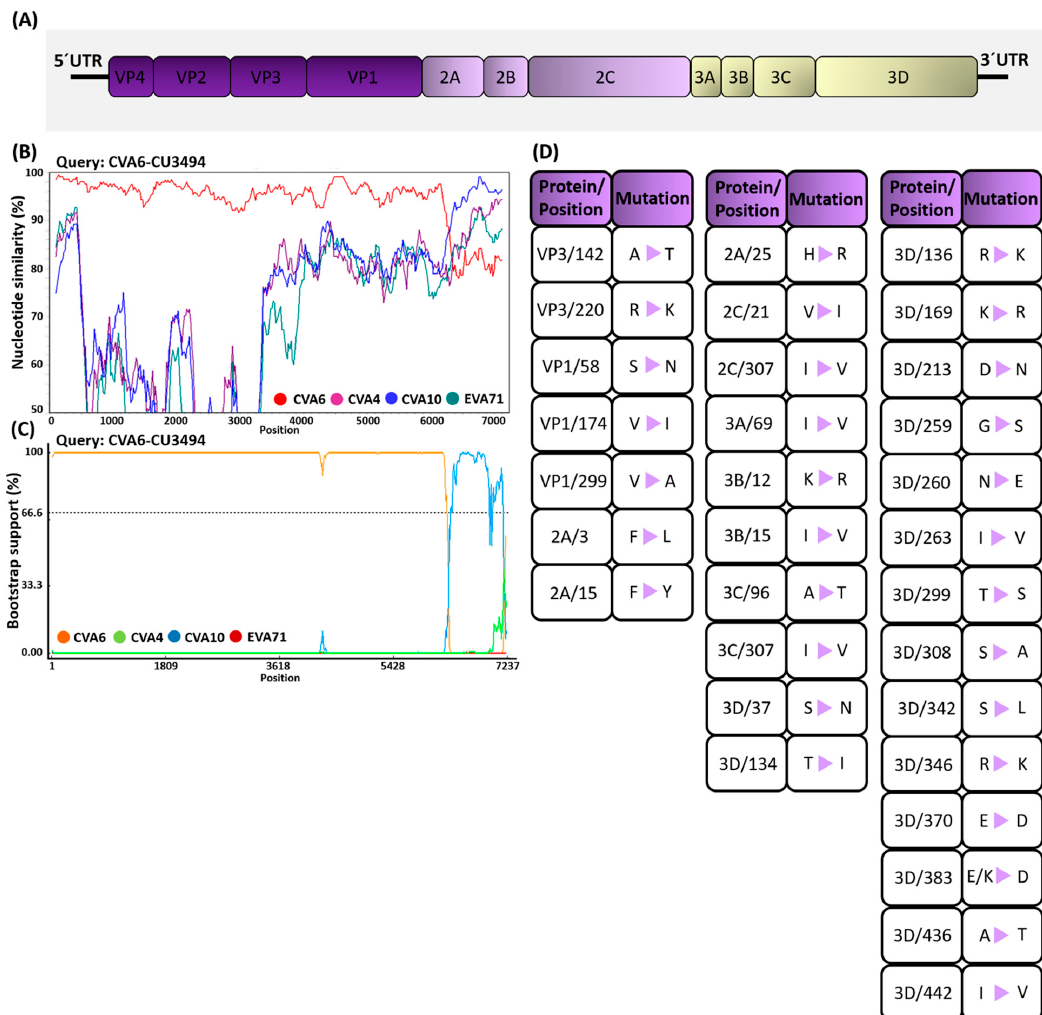
Figure 5. ( A ) Schematic diagram of the enteroviral (EV) genome structure. ( B ) Recombination analysis of putative recombinant coxsackievirus (CV)-A6 strains. SimPlot analysis of the recombinant strain CVA6-CU3494. The vertical axis represents the nucleotide sequence similarity (%) between the putative recombinant strain and other EV-A lineages, constructed using SimPlot v3.5.1 with a window size of 200 nt and a step size of 20 nt. ( C ) Bootscan plot of recombination events between the daughter strain EVA71-CU3494 and major (CV-A6) or minor (CV-A10) parental strains. The bootstrapping support value was computed using the RDP4 program with a window size of 200 nt, a step size of 10 nt, and 1000 bootstrap replicates. ( D ) Amino acid changes between the CV-A6 subclade and the D3/A and D3/Y strains.